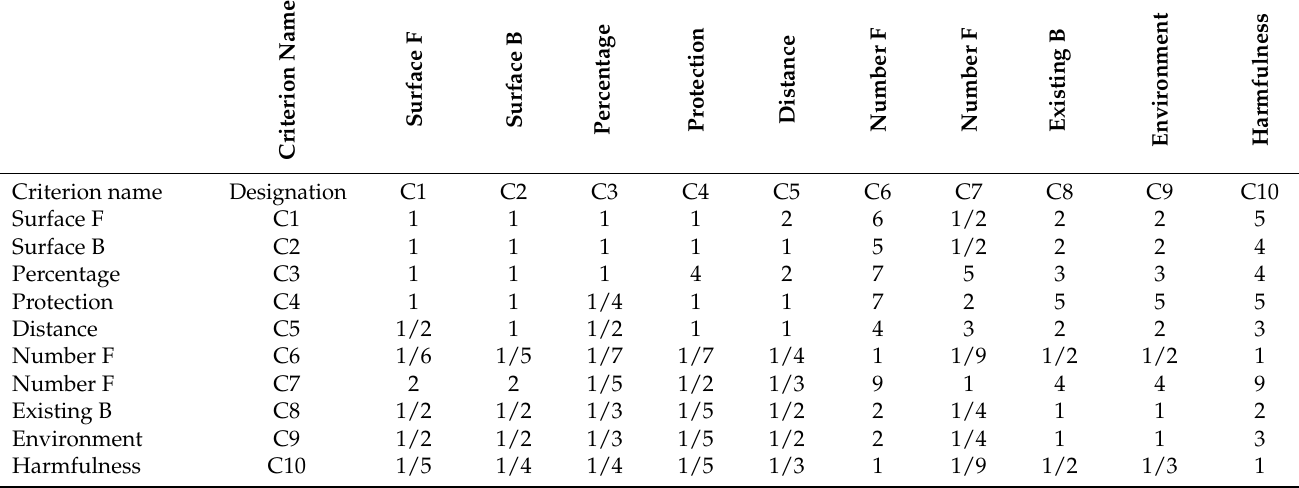
Table 6. Relationship between criteria according to the Saaty scale (AHP).